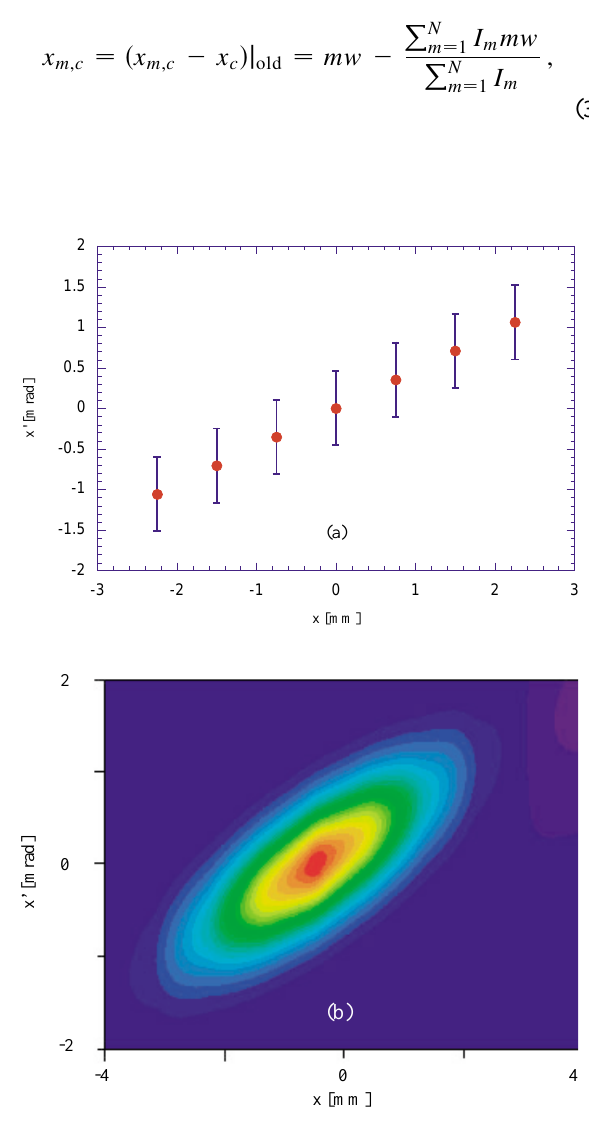
FIG. 2. (Color) (a) Beam trace space constructed from the beam- let intensity profile illustrated in Fig. 1. Each point represents the position of a beamlet in trace space and the error bars in- dicate the thermal spread of the beamlets. (b) Contour plot representation of the same data. Here the relative weights of the beamlets are